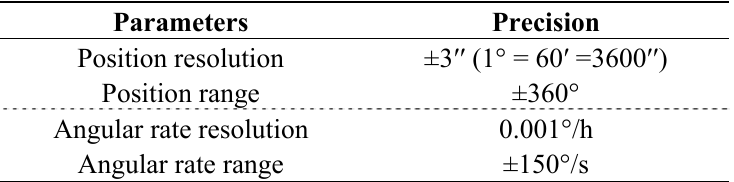
Table 8. Specifications of the SGT-3